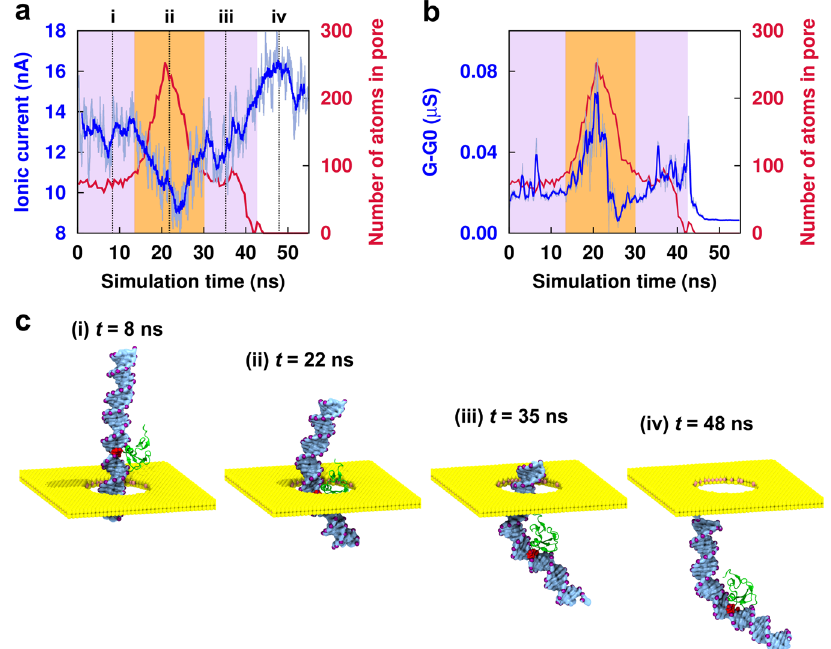
Fig. 4 Detection of DNA methylation with MoS 2 nanopores by either ionic current or transverse electronic sheet current measurement. a A typical ionic current trace together with the number of DNA/protein atoms residing in a MoS 2 pore when a mDNA-MBD complex translocates through the pore. b Calculated differential conductance in the MoS 2 layer during the same translocation event as in a. c Successive snapshots from MD trajectory showing the translocation of the mDBA-MBD1